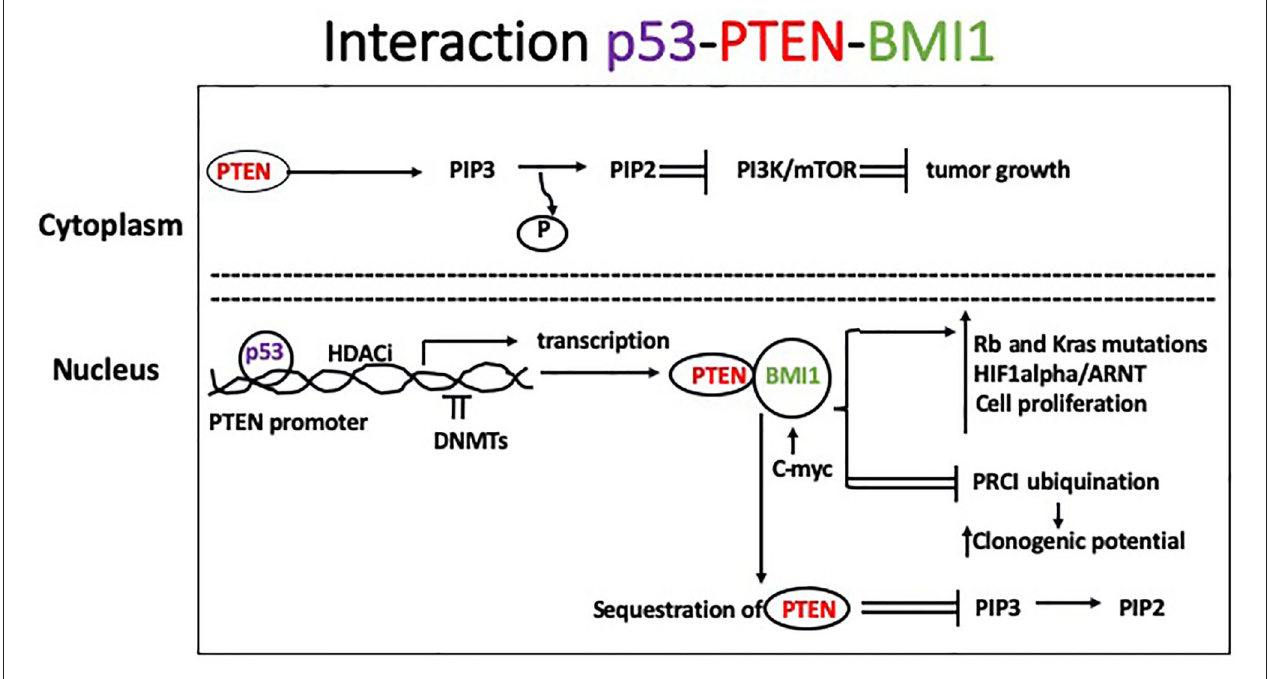
FIGURE 1 | In the cytoplasm, PTEN mediates dephosphorylation of PIP3 to PIP 2 which inhibits the PI3k/Akt/mTOR signaling pathway leading to slower tumor growth. Histone deacetylase inhibitors activate PTEN nuclear translocation, whereas DNMTs cause hypermethylation of PTEN promoter and loss of its activity, which has been described during tumor progression. Binding of p53 to the PTEN promoter induces its transcription. Additionally, BMI1 binds to the PTEN protein in the nucleus inhibiting its expression. Consequently, BMI1 reduces PTEN’s ability to inhibit Akt activation in the cytoplasm. Common features observed in BLBC include mutations of the tumor suppressor Rb and the oncogene K-ras , and increased activity of Myc and HIF1 α )/ARNT, leading to increased cell proliferation.